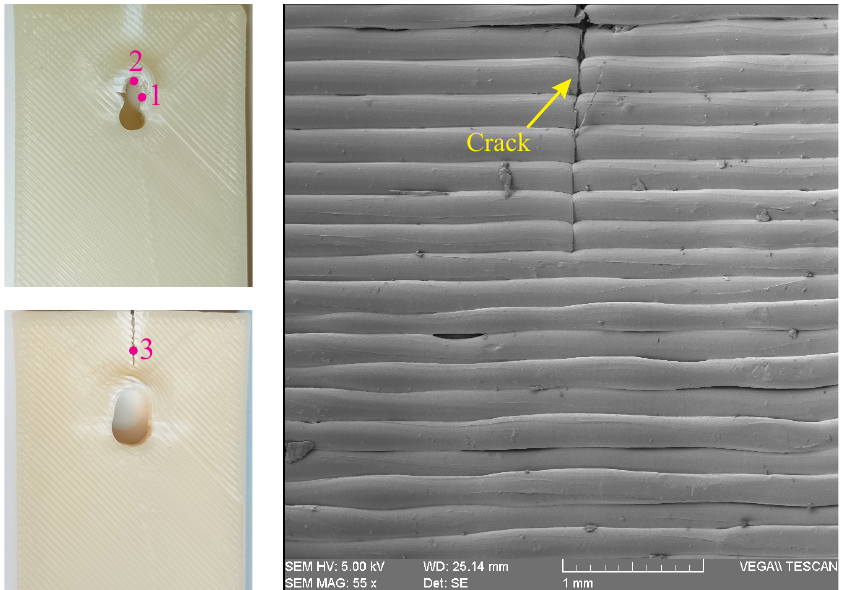
Figure 9. Reference points in visual inspection of specimens ( left ), and SEM image of point 1 of a 3D-printed ABS specimen with hole diameter of 12 mm ( right ).